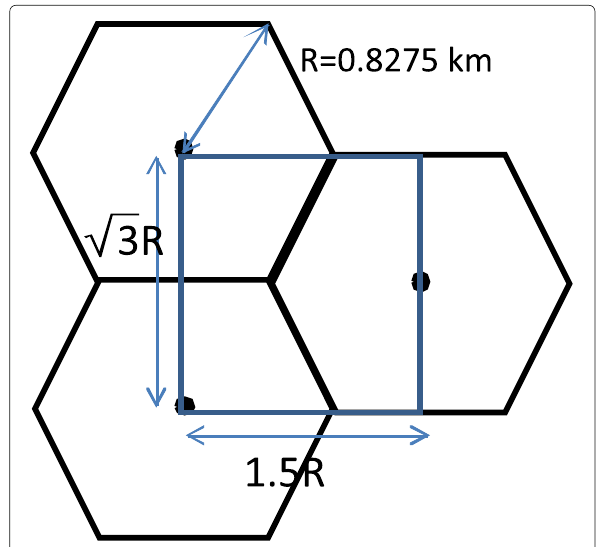
Fig. 9 Fragment of the considered cellular